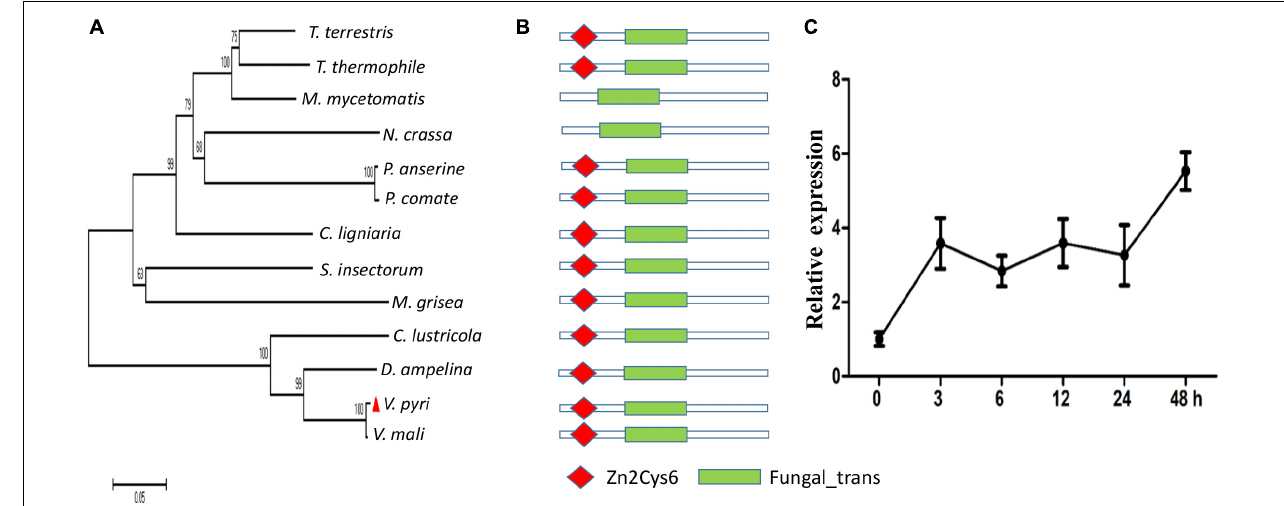
FIGURE 1 | Identification and transcript expression analysis of VpFSTF1 during V. pyri infection of pear. (A) Phylogenetic analysis of fungal VpFSTF1 proteins. Fungal-specific transcription factor sequences were downloaded from the NCBI database. The sequences were aligned using the Clustal W tool, and a phylogenetic tree was constructed by the neighbor-joining method using MEGA 7.0 software. The confidence levels above the nodes were obtained from 1000 bootstrap analysis. (B) Main domains of VpFSTF1. The domain architecture of VpFSFT1 and its orthologs were predicted with SMART. (C) Transcriptional expression analysis of VpFSTF1 during V. pyri infection of pear. The relative levels of VpFSTF1 in V. pyri were quantified by qRT-PCR and normalized to the transcript levels of the V. pyri actin gene. Fold changes were calculated by the 2 − (cid:49)(cid:49) Ct